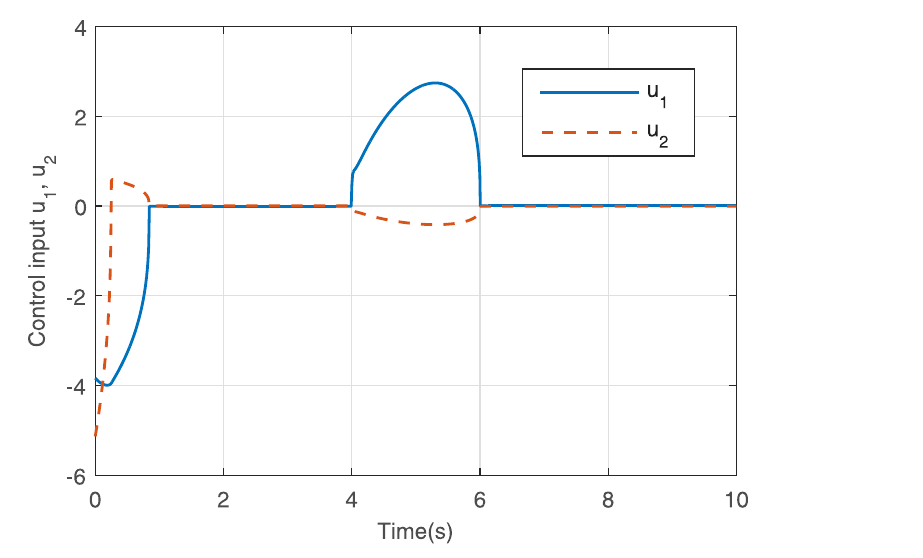
Fig 7. Response curves of the output feedback signal.